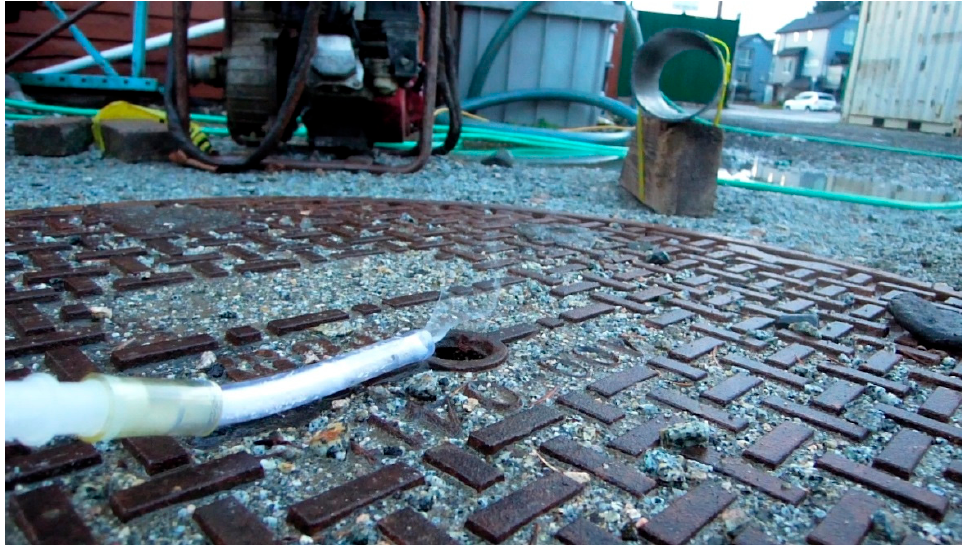
Figure 5. Upward deflection of ‘smoke’ at the opening in the manhole cover.